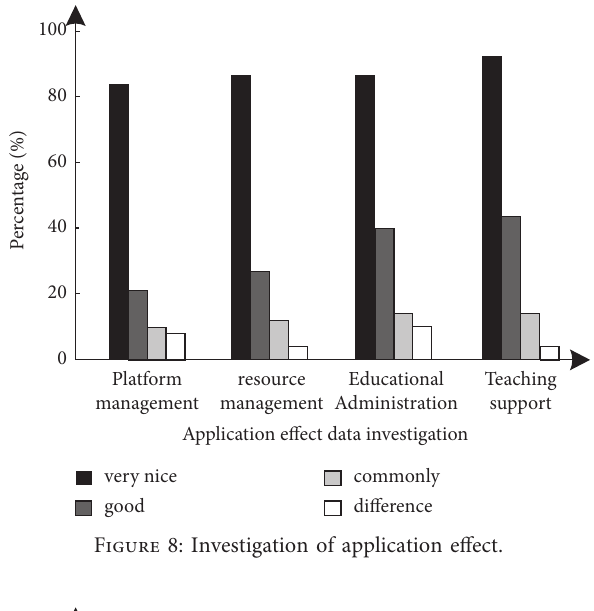
Figure 10: The cumulative distribution function of the user